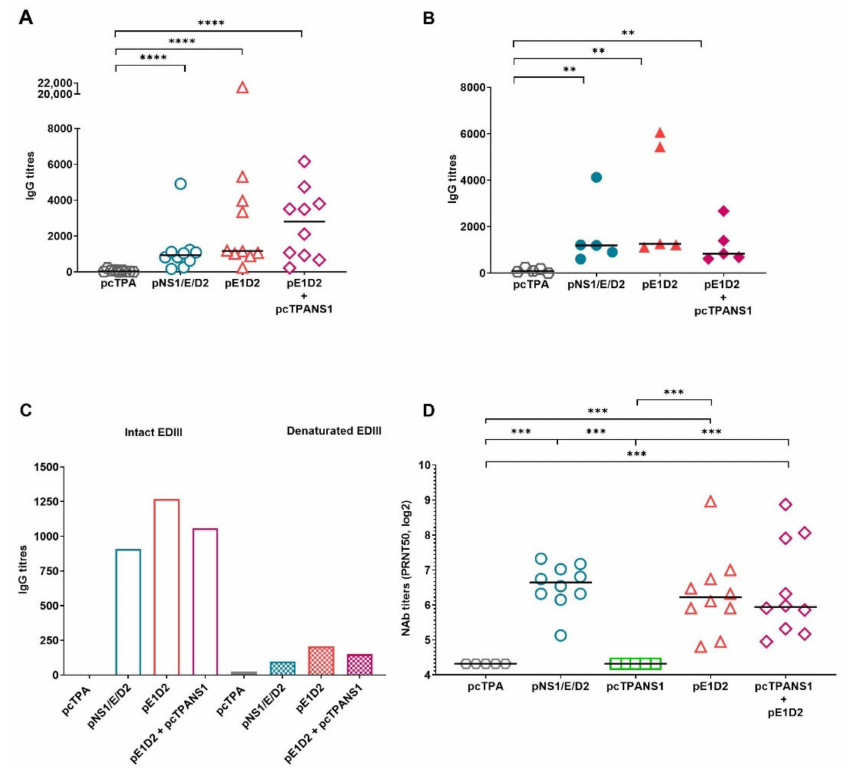
Figure 4. Antibody response directed to the E protein in serum samples of BALB/c mice immunized with E-derived DNA vaccines . Antibody titration against the EDIII protein by ELISA ( A – C ) and PRNT 50 ( D ) using serum samples from mice immunized with pNS1/E/D2, pcTPANS1, and pE1D2, alone or in a mixture of pE1D2 + pcTPANS1 ( n = 5–10), and the control group inoculated